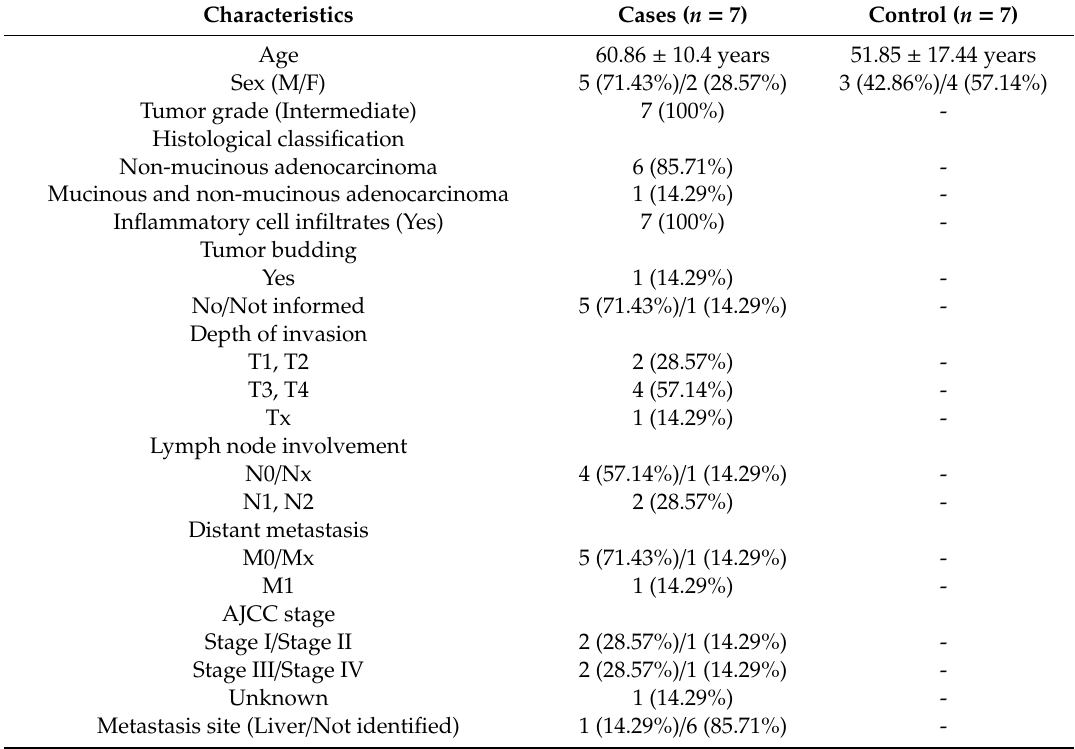
Table 1. Clinical characteristics of patients at diagnosis.